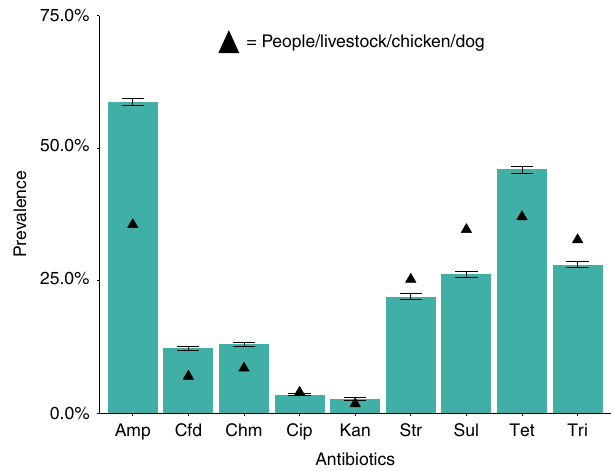
Fig. 3 Prevalence of antimicrobial-resistant bacteria in wildlife. Bacteria isolated from fecal samples collected from wildlife ( n = 5464 isolates) compared to mean prevalence of resistance from people/livestock/ chicken/dog combined (triangles; n = 54,978 isolates). Wildlife fecal samples were opportunistically collected from wildebeest (Connochaetes taurinus), zebra (Equus quagga), impala (Aepyceros melampus), giraffe (Giraffa camelopardalis), elephant (Loxodonta africana), gazelle (Eudorcas thomsonii), dik-dik (Madokua kirkii), and buffalo (Syncerus caffer). Antibiotics included amp (ampicillin), cfd (ceftazidime), chm (chloramphenicol), cip (cipro fl oxacin), and kan (kanamycin), str (streptomycin), sul (sulfamethoxazole), tet (tetracycline), tri (trimethoprim). Error bars are 95% standard